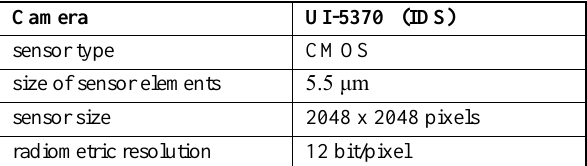
Table 1. Data of the industrial camera